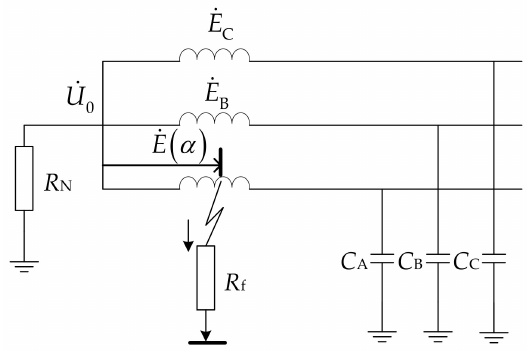
Figure 1. Stator winding phase A ground fault diagram.